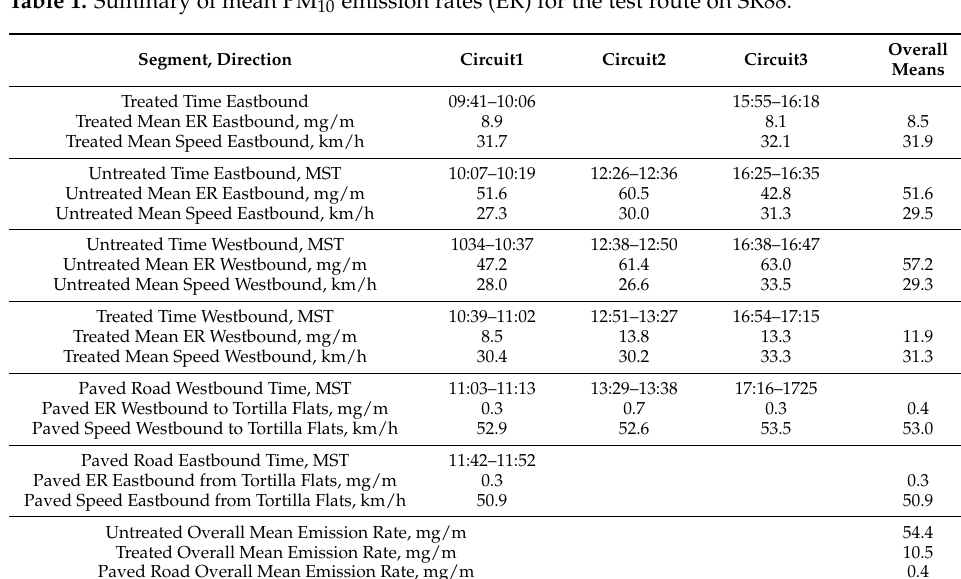
Table 1. Summary of mean PM 10 emission rates (ER) for the test route on SR88. Segment, Direction